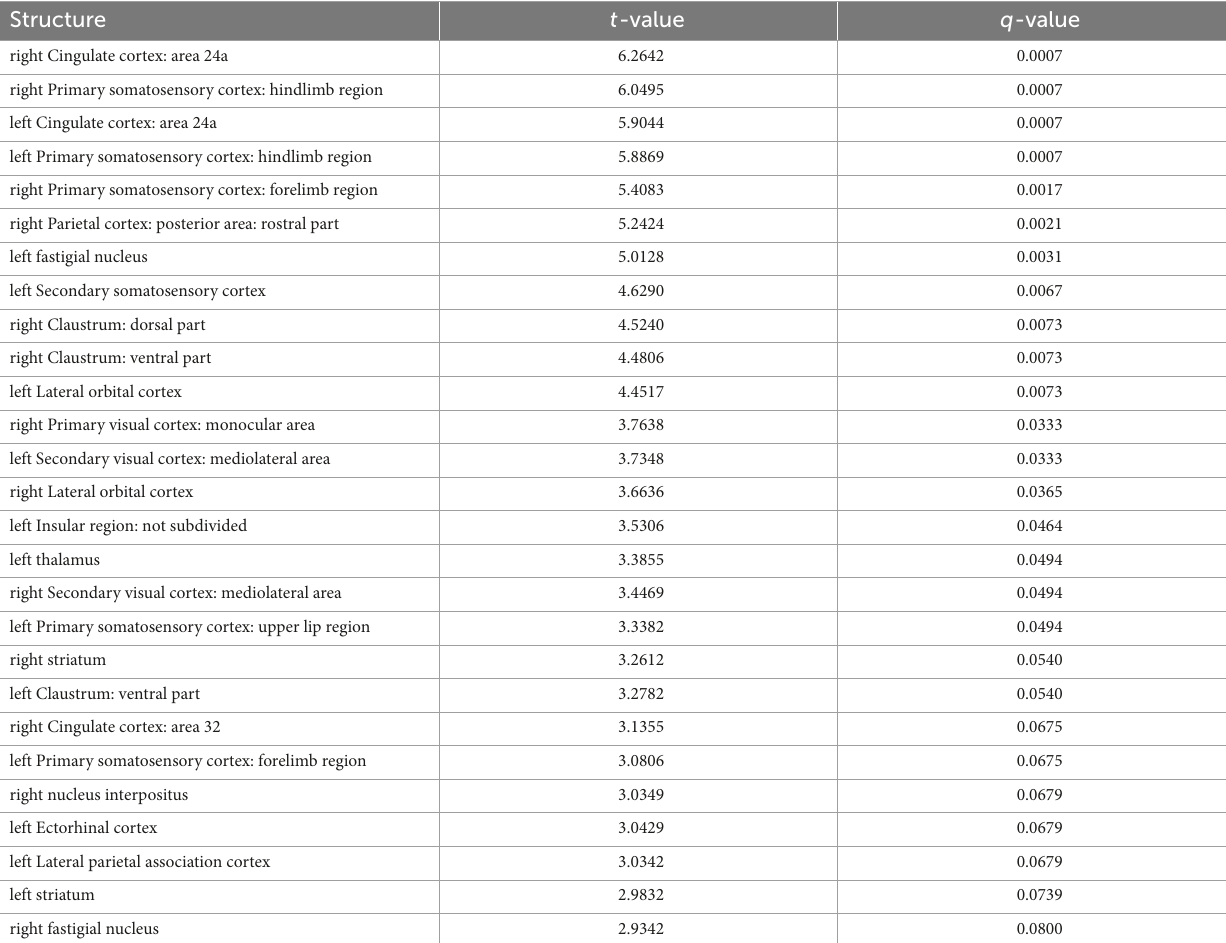
TABLE 1 Brain structures showing an increase in volume following 7,8-DHF